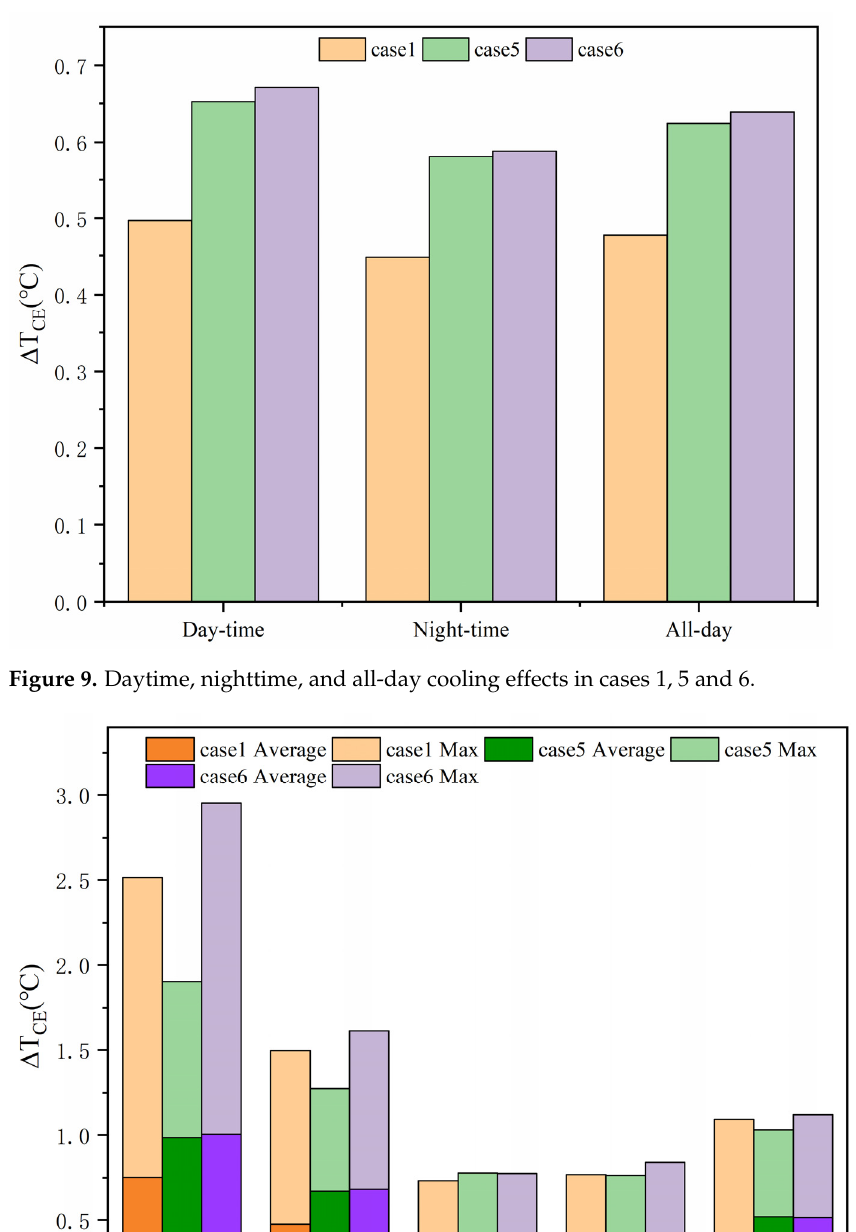
Figure 11. Distribution of temperature in cases 1, 5, and 6 at 14:00. 4. Discussion 4.1. The Effect of Wind Direction on the Cooling Effect Just as water exerts a cooling effect on the air flowing over the water surface, the wind direction also influences the cooling effect of water bodies. From the temperature distribution experiment above, we can see that temperature was gradually reduced with changes in wind direction. When the water body was located in the windward area of the dominant wind direction in summer, the cooling effect of the water body could impact a larger area [22]. When the position of the water body is fixed, cold wind ‐ driven air flowing over the water surface decreases the temperature in the downwind area significantly [35].